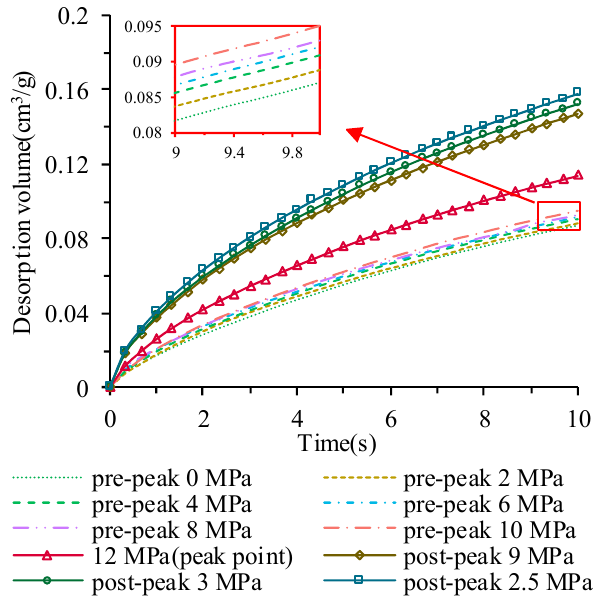
Figure 3. Released methane volume in the coal under different stresses. Energies 2018 , 11 , x FOR PEER REVIEW